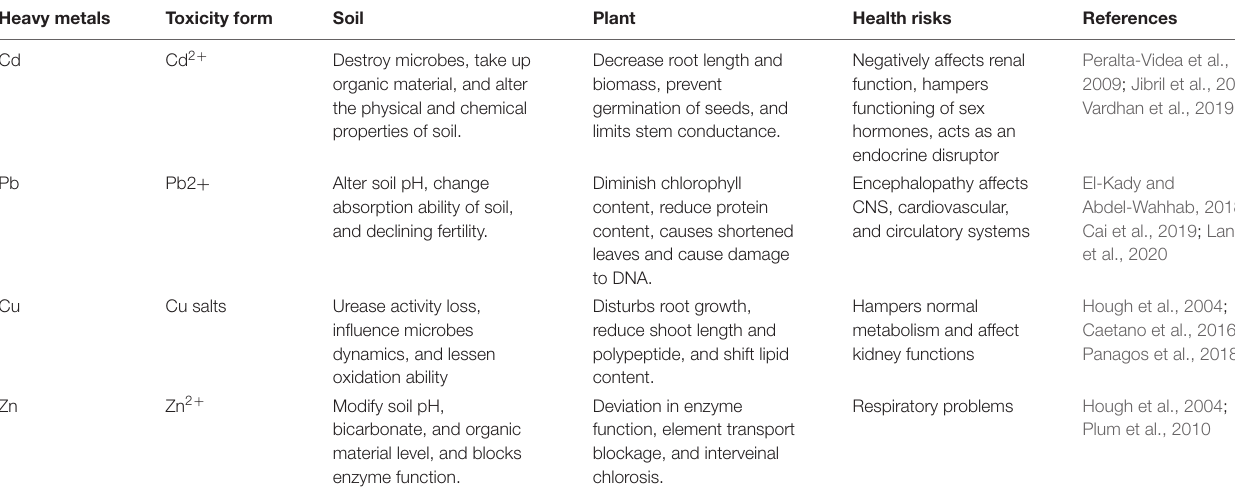
FIGURE 1 | The primary sources and effects of heavy metal exposure at various trophic levels. TABLE 1 | Various types of heavy metal toxicity and their harmful effects on soil, plants, and